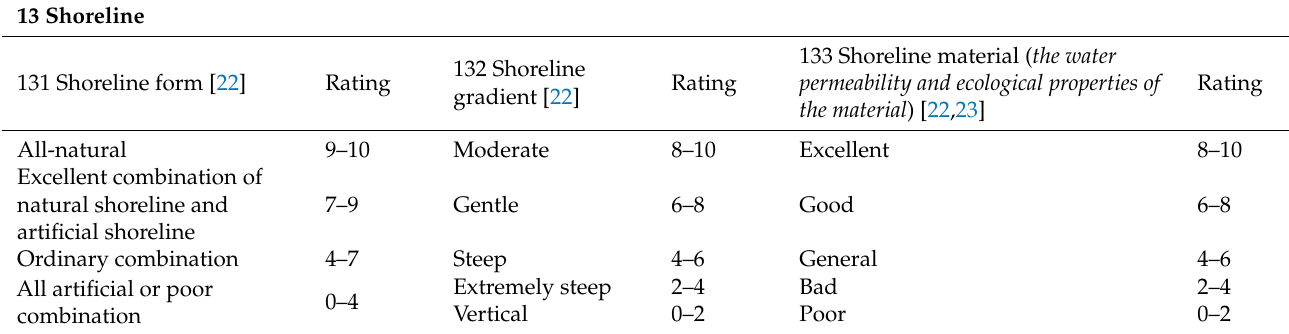
Table 8. Rating for elements of shoreline layer in ecological subsystem.